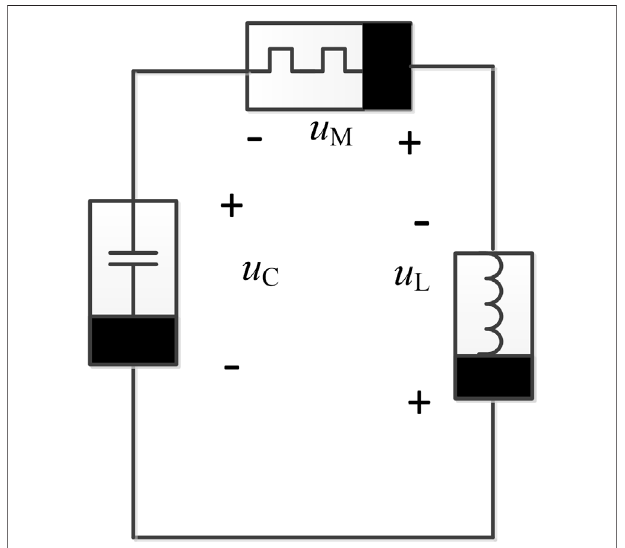
FIGURE 4 | Circuit of the chaotic system.